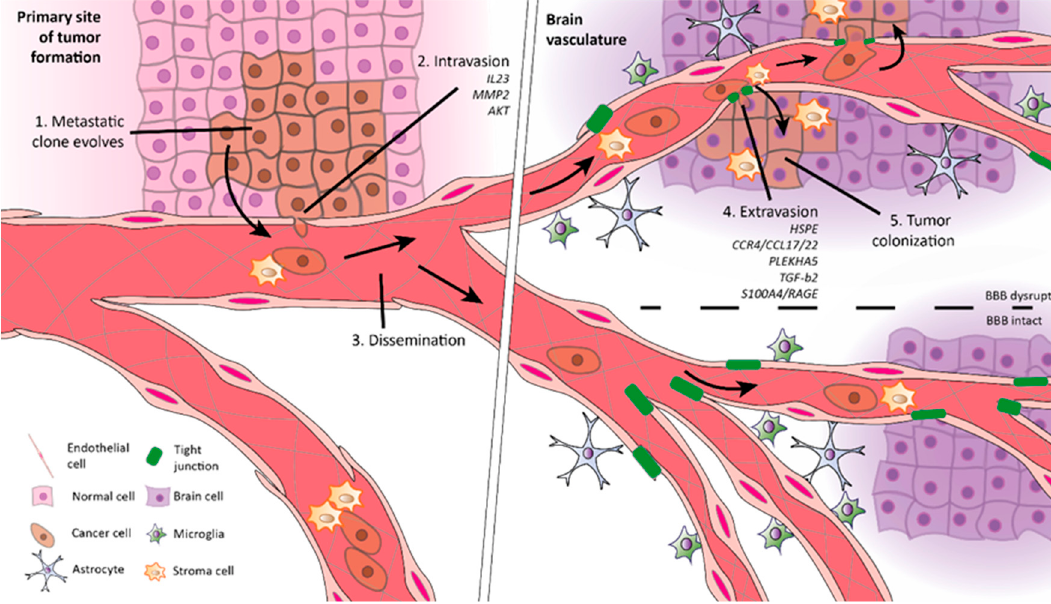
Figure 1. Steps in the formation of brain metastases (BM). Metastases formation begins in the microenvironment of the primary tumor with 1. metastatic clones developing, degrading the extracellular matrix (ECM), and suffering an epithelial–mesenchymal transition (EMT) to further detach from the connective tissue. 2. Subsequently, tumor cells invade and enter the circulation (intravation). 3. The dissemination within the vascular system drives tumor cells to distant sites, like the brain. 4. Then, they extravasate across the blood–brain barrier (BBB) and enter the brain parenchyma due to the release of proteolytic enzymes and cellular interactions. 5. Once inside the brain, cancer cells colonize the tissue and develop secondary tumors.